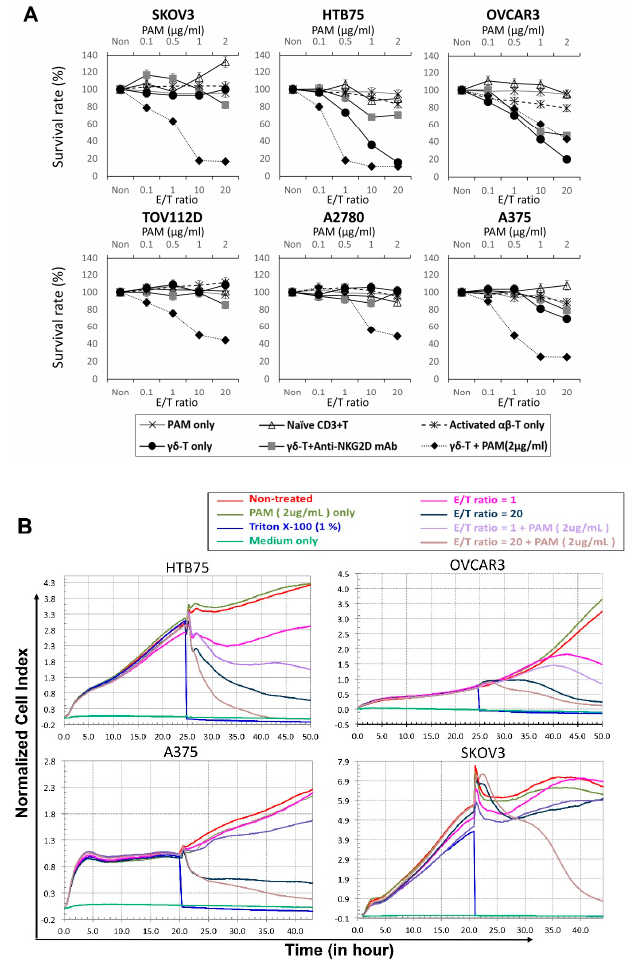
Figure 2. Specific suppression of epithelial ovarian cancer cell lines (HTB75 and OVCAR3), and a melanoma cell line (A375) by expanded V γ 9V δ 2 T-cells alone. ( A ) Standard 24-h cytotoxicity activities were performed with many replicates ( n > 12) with increasing effector (V γ 9V δ 2 T-cells) concentrations to target E/T ratios of 0, 0.1, 1, 10, and 20 against the cancer cell lines: OVCAR3, HTB75, SKOV3, TOV112D, A2780 and A375. Cytotoxic activities were compared to the Pamidronate (PAM) treated alone, V γ 9V δ 2 T-cells + anti-NKG2D mAb, V γ 9V δ 2 T-cells + PAM (2 µ g/mL) treated, and activated αβ T-cell- and naïve CD3 + T-cell-treated served as the controls of V γ 9V δ 2 T-cells ( n = 12–20; significance range at * p = 0.035 ~ **** p < 0.0001). ( B ) Real-time monitoring of cytotoxic activities were compared to the PAM (2 µ g/mL) treated alone, V γ 9V δ 2 T-cells + PAM (2 µ g/mL) treated, and Triton X-100 (1%) treated served as the positive control. Real-time monitoring of γδ T- cell-treated alone induced growth inhibition of epithelial-type cells: OVCAR3, HTB75, whereas combination of V γ 9V δ 2-T cells + PAM treatment enhanced growth inhibition of all the cells, including OVCAR3, HTB75, A375 and SKOV3 using the x-CELLigence system. Data are presented as the mean ± SD of three independent